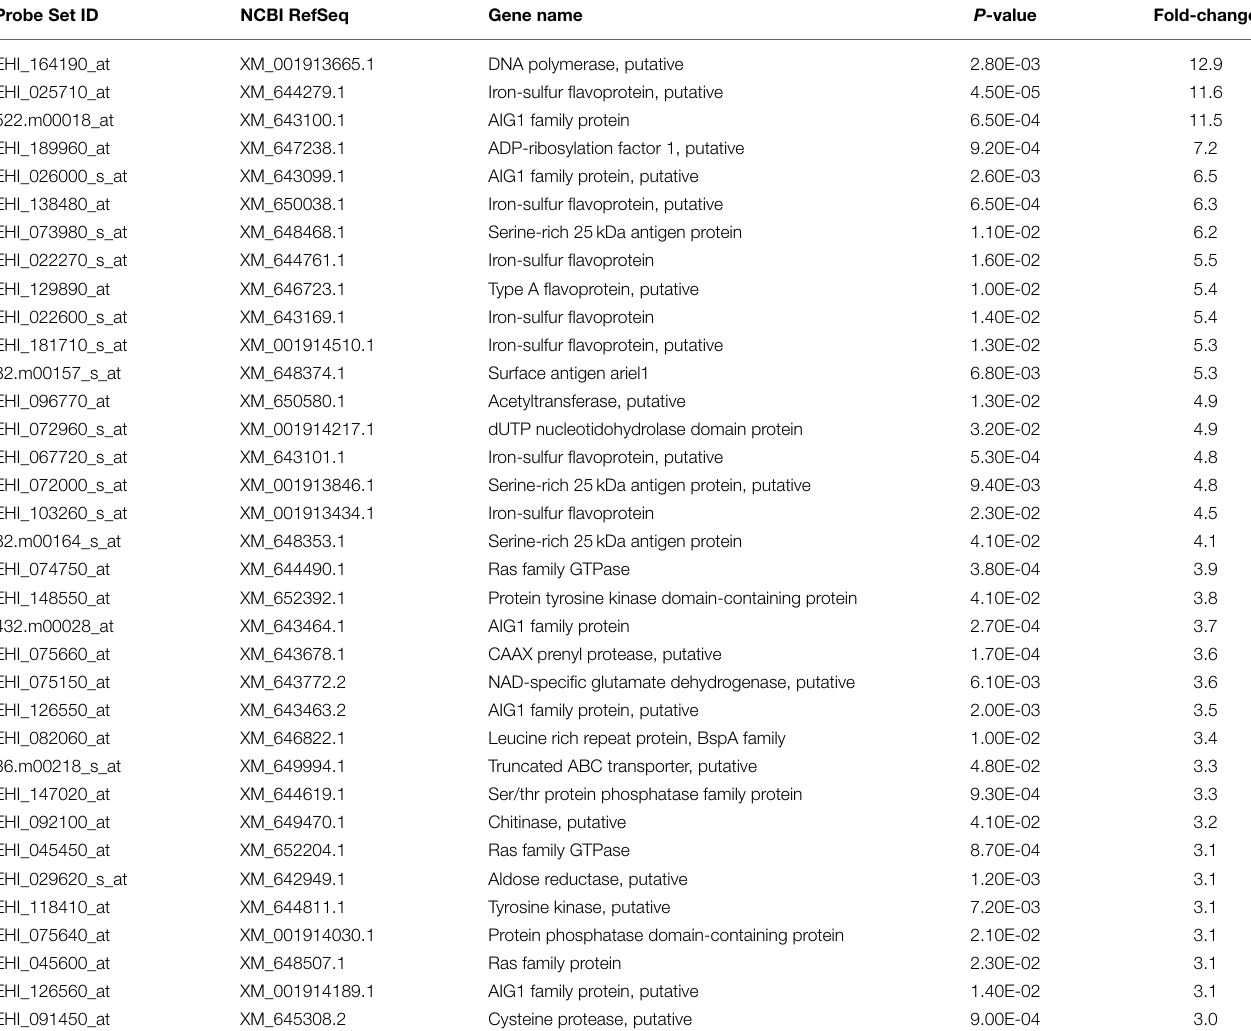
TABLE 2 | List of annotated genes that were upregulated in MTZR by > 3 fold compared to HM-1. Probe Set